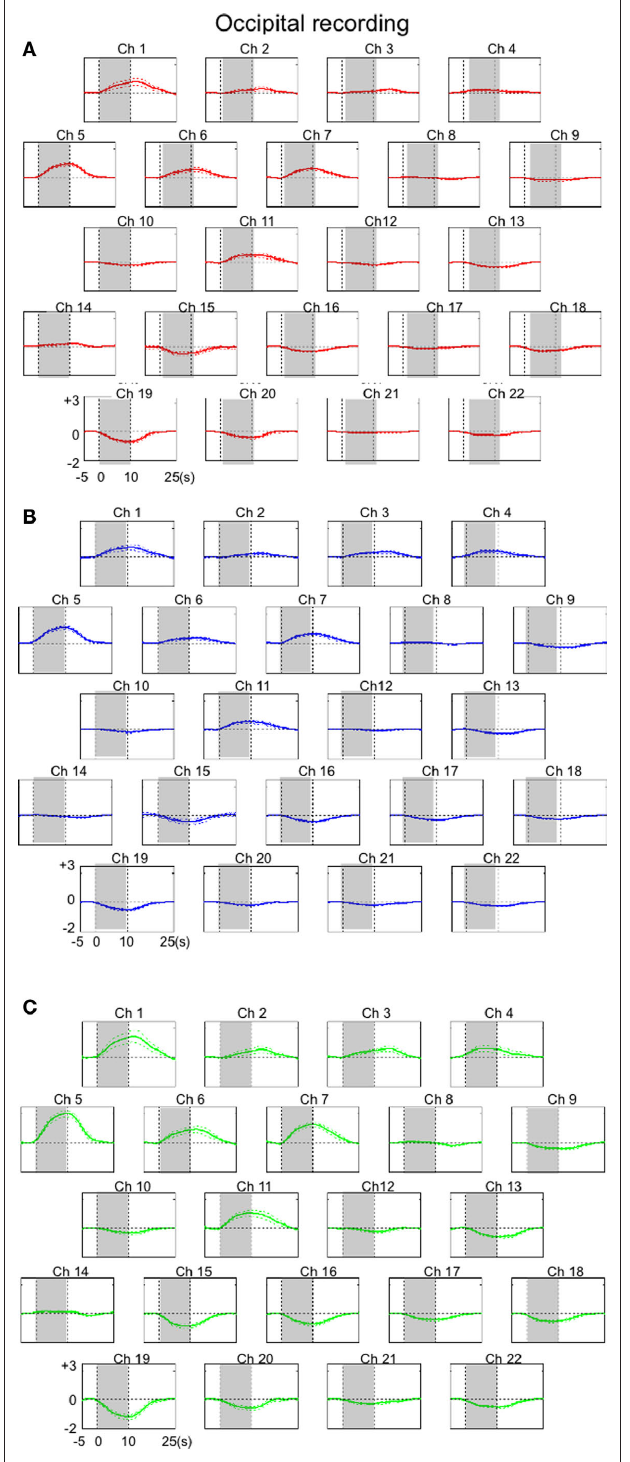
Figure 3 | The results of overall hemodynamic changes observed for 22 occipital cortical channels (Ch). Averaged hemodynamic changes ( ± SE) for oxy-Hb (A) , deoxy-Hb (B) , and total-Hb (C) . Channels with relatively small numbers were a located in more anterior portions of the recorded area. Shades indicate a 10-s stimulation period. Units of hemodynamic change are given as